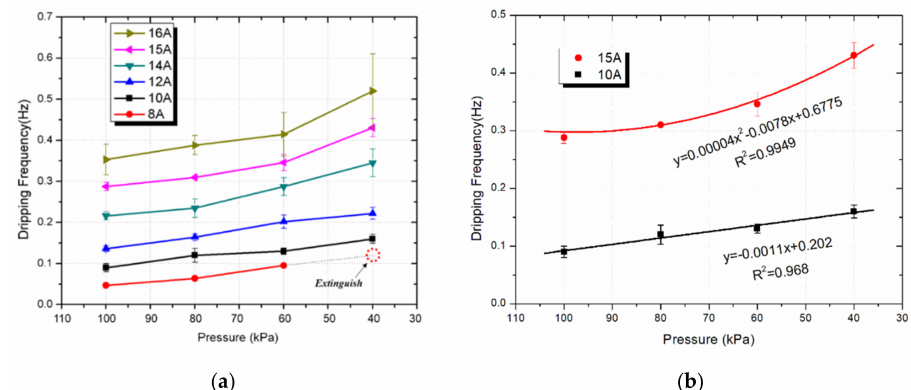
Figure 4. Dripping frequency at various pressures for the energized wire: ( a ) wire under various currents; ( b ) the different growth rates for wire under specific currents.